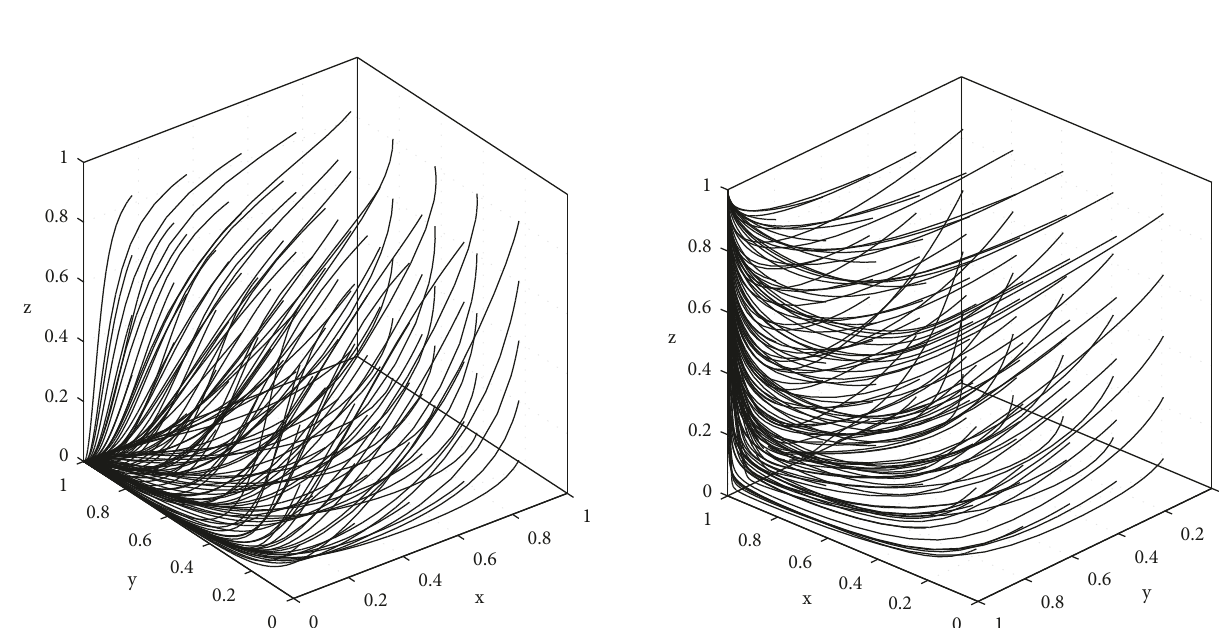
Figure 7: Dynamic evolution path of case 6.